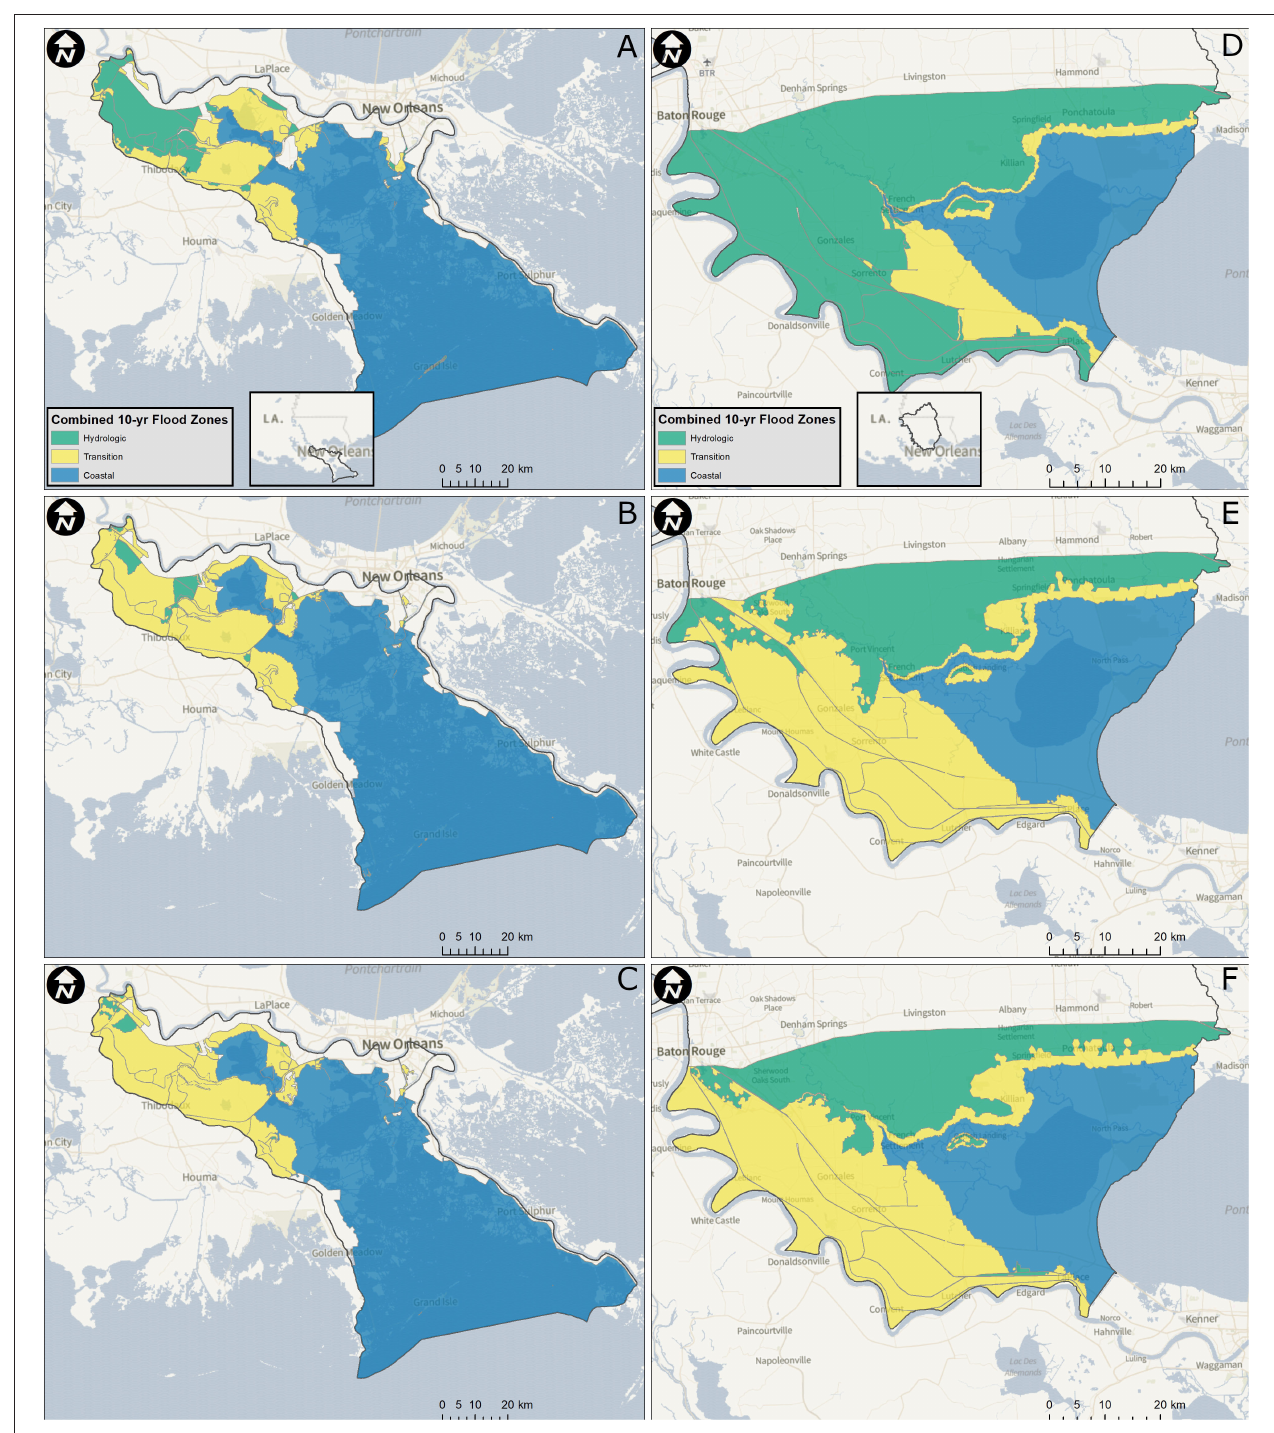
FIGURE 12 | Flood zone delineation for (A–C) Barataria watershed and (D–F) Lake Maurepas watershed for the (A,D) 10-year, (B,E) 50-year, and (C,F) 100-year return period storm surge stillwater elevation. Basemap courtesy of Mapbox.